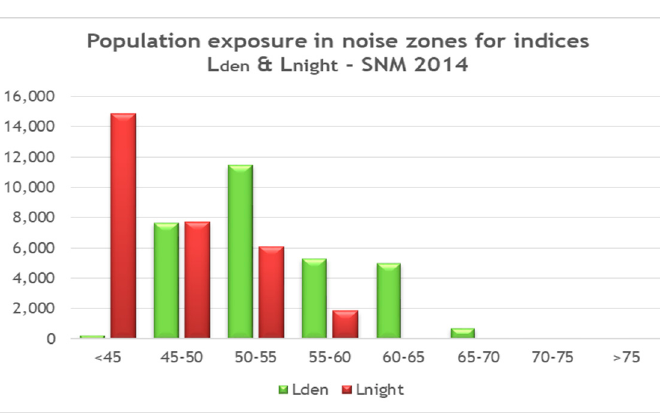
Figure 6. Corfu SNM—population exposure in noise zones for indices L den & L night.